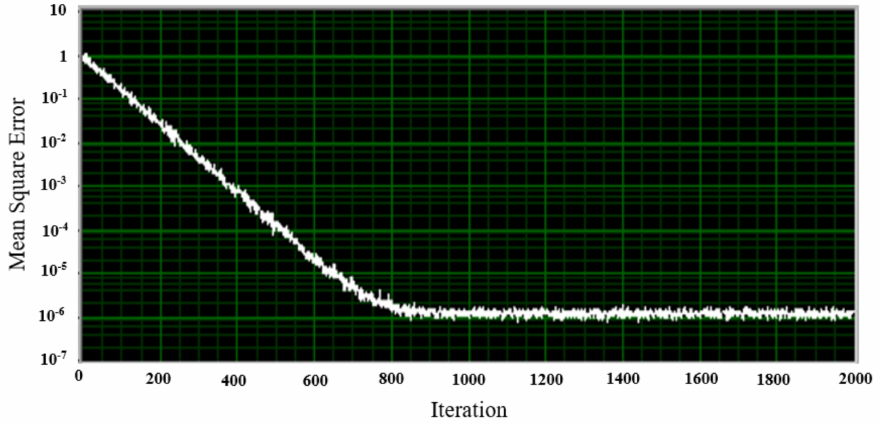
Figure 11. Learning curve of the LMS adaptive filter